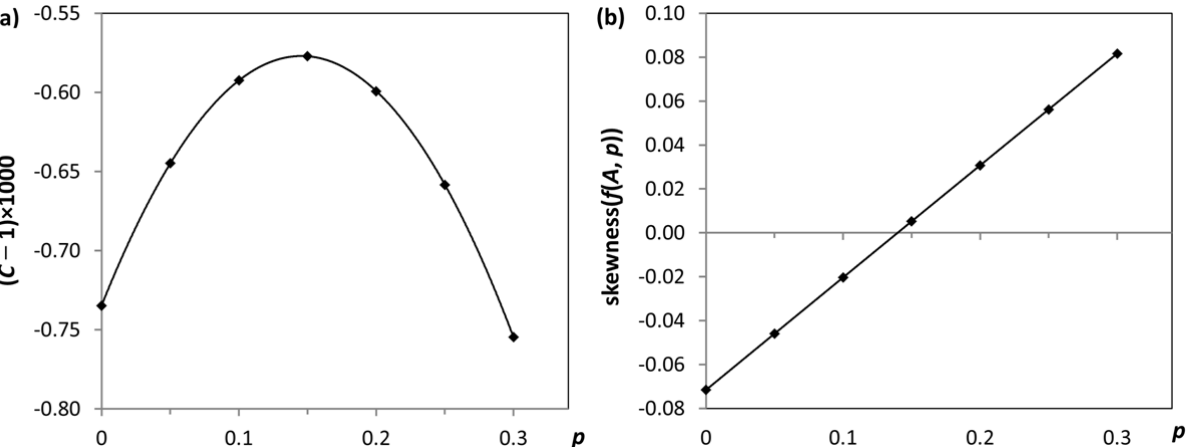
Figure 5. Two methods of finding the optimal parameter p of the Box–Cox transformation: ( a ) By maximizing the correlation coefficient C of the normal probability plot; ( b ) By finding the value of p yielding a zero skewness of the distribution of f ( A , p